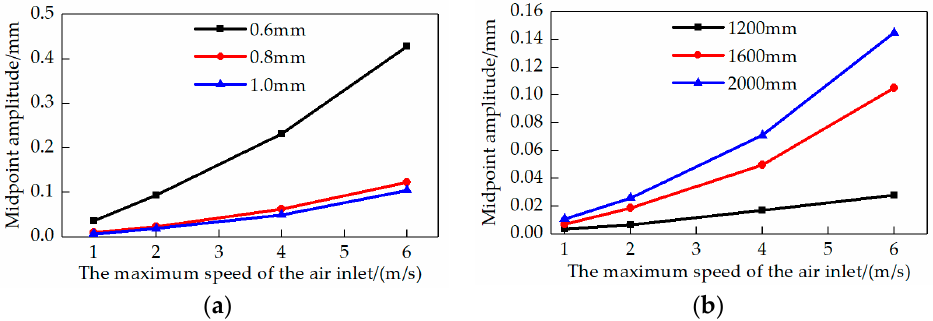
Figure 8. The midpoint amplitude changes of di ff erent strips with maximum speeds of the air inlet. ( a ) Di ff erent thicknesses; ( b ) di ff erent